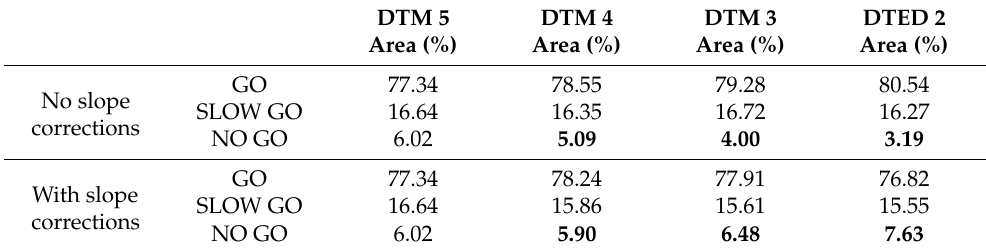
Table 9. The comparison of the extent of passable, hardly passable, and impassable areas with different elevation models without slope corrections and with slope corrections. Combined 5 areas, 3 km × 3 km, moist conditions, GO max slope = 10 ◦ , SLOW GO max slope = 20 ◦ . The main improvements in the results are displayed as bold values.